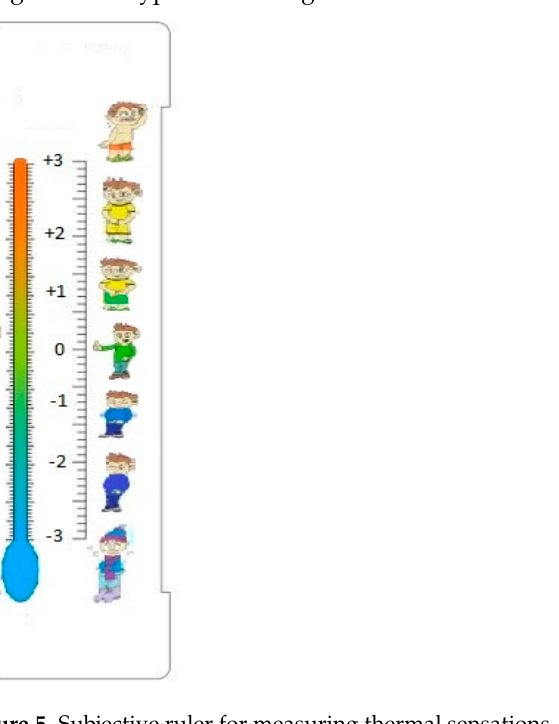
Figure 5. Subjective ruler for measuring thermal sensations.